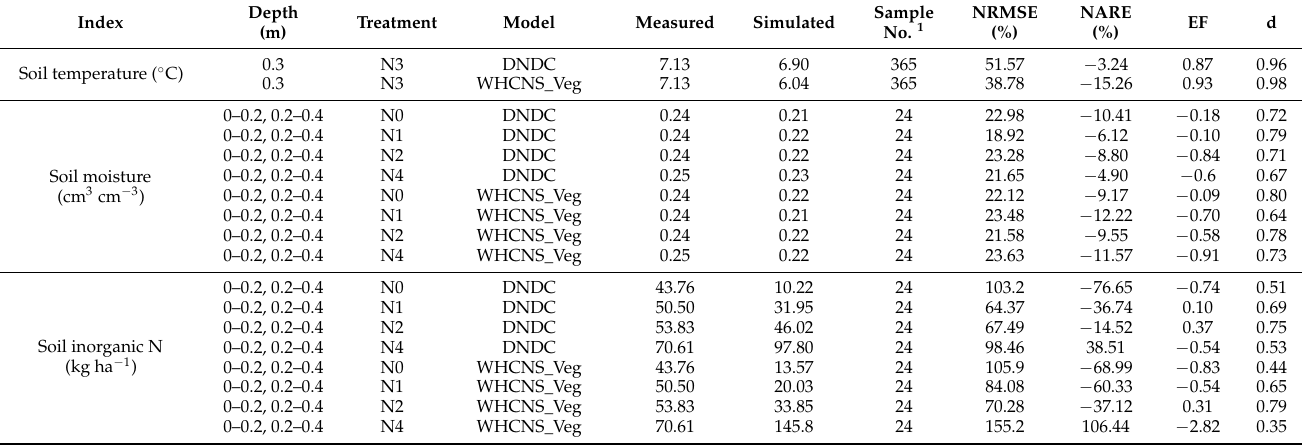
Table 6. Statistical validation between the simulated and measured soil temperature, soil moisture and soil inorganic nitrogen under different N treatments using the DNDC and WHCNS_Veg models in Wuchuan,